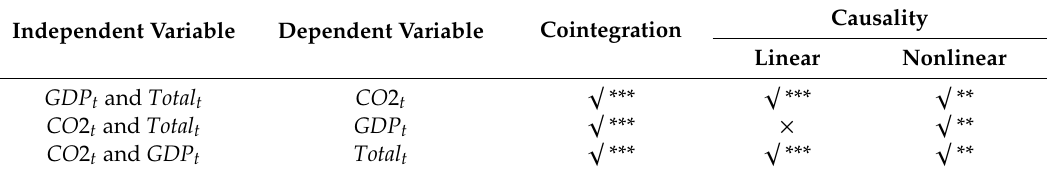
Table 11. Summary of multivariate cointegration and causality